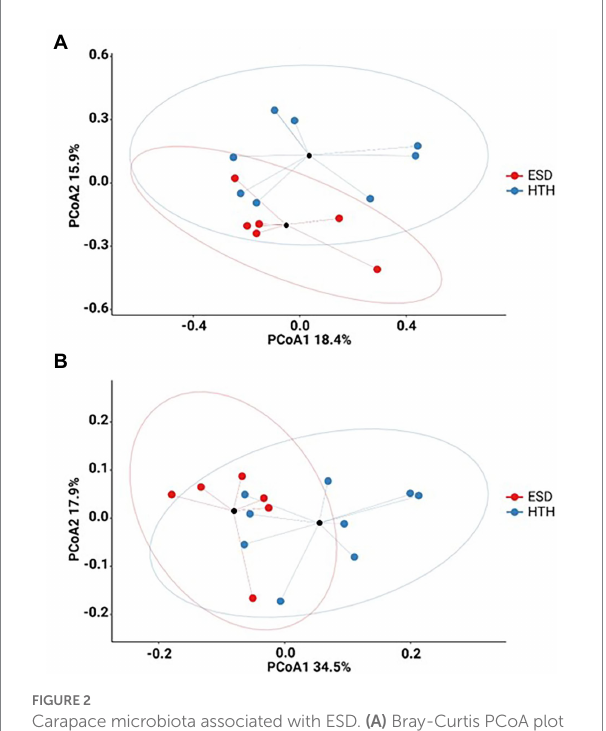
FIGURE 2 Carapace microbiota associated with ESD. (A) Bray-Curtis PCoA plot (PERMANOVA, p = 0.018). (B) Weighted UniFrac PCoA plot (PERMANOVA, p = 0.024). Carapace microbiota from ESD (red) was significantly different from HTH (blue). The black circles represent the mean values, and ellipses indicate 95% confidence intervals.